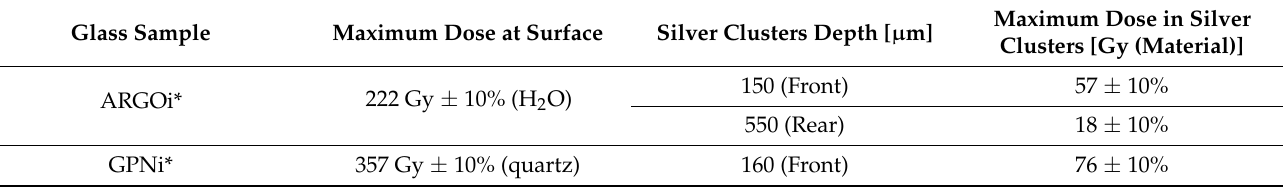
Table 3. Deposited doses for each considered silver